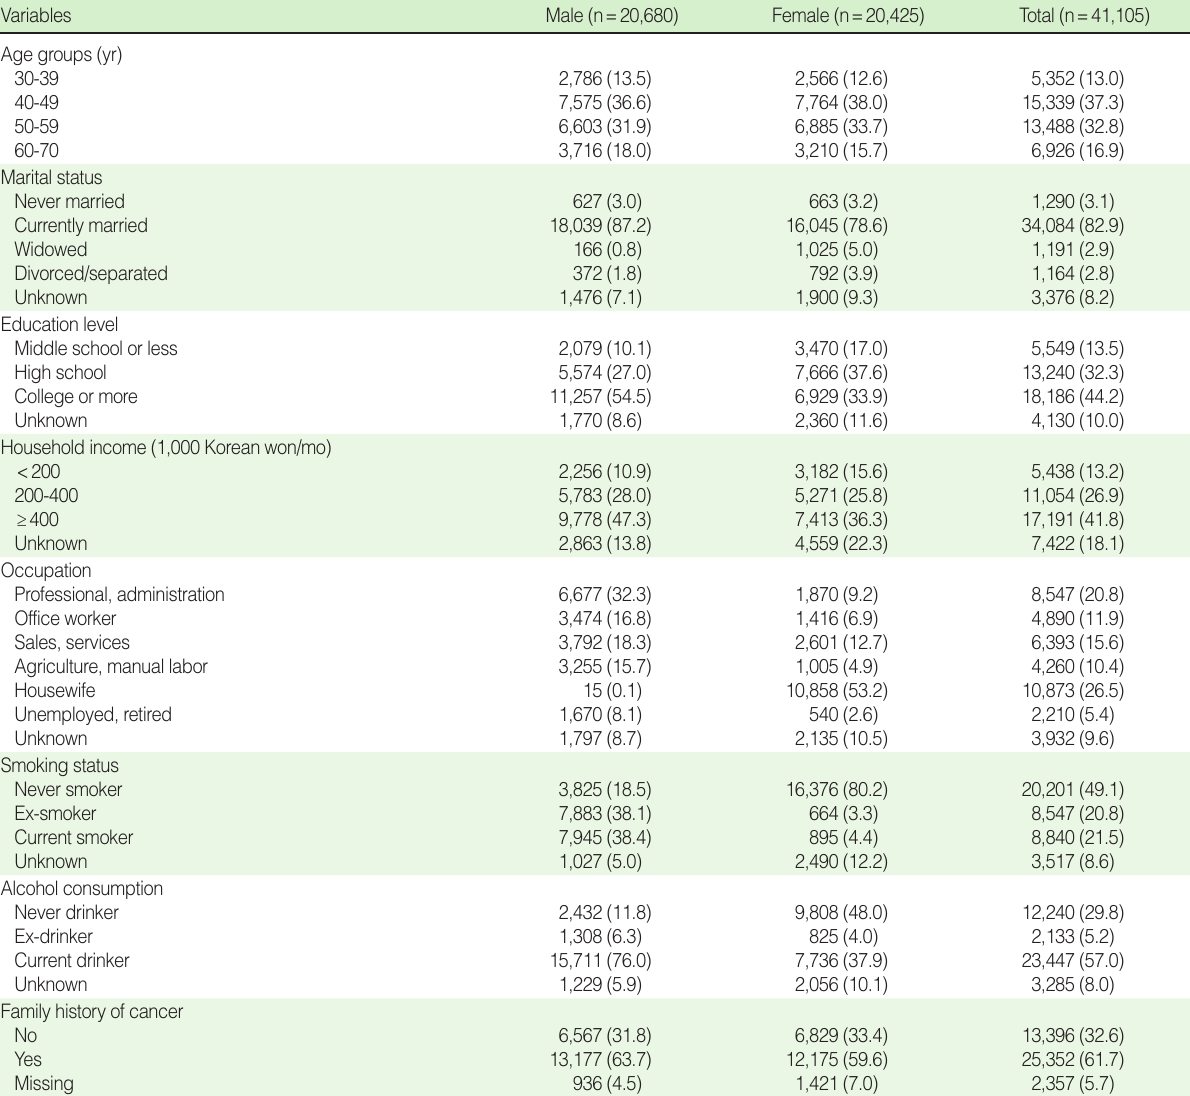
Table 1. Distribution of selected demographic factors in this cohort